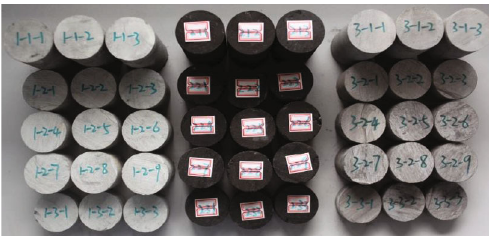
Figure 3: No. 4 coal seam rock formation specimens.